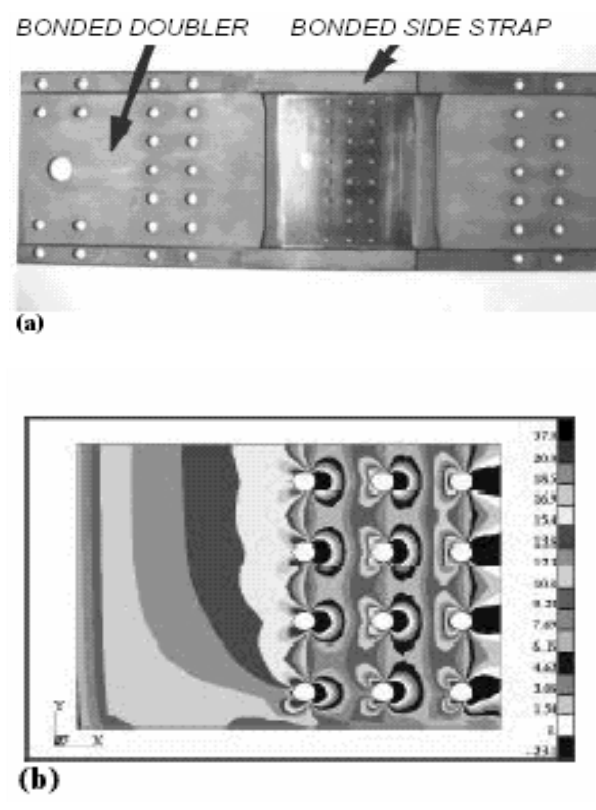
Fig 1. Illustration of MSD specimen (a) bonded doubler, (b) with a hoop stress distribution at faying surface by finite element